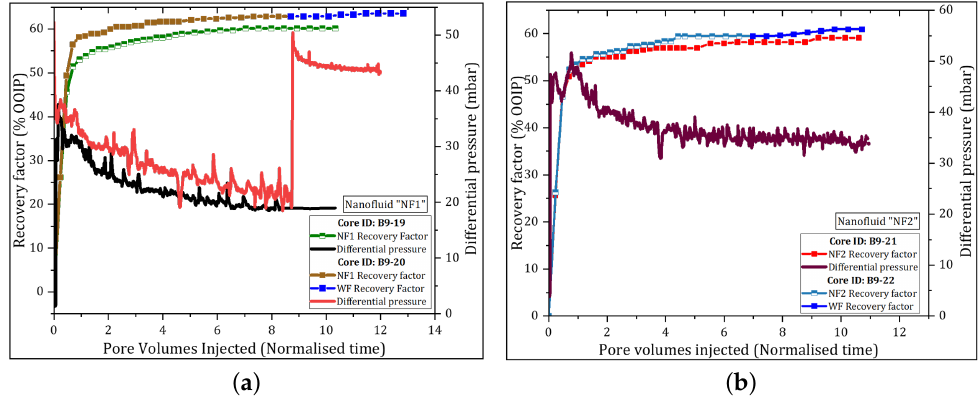
Figure A1. Secondary oil recoveries and dP versus PVs recorded through the duration of nanofluid flooding. Two tests were conducted for each nanofluid. WF was conducted only in replicate test at 0.5 mL/min. ( a ) NF1 (dP = 20 mbar); ( b ) NF2 (dP = 34 mbar), the pressure failed to record properly.